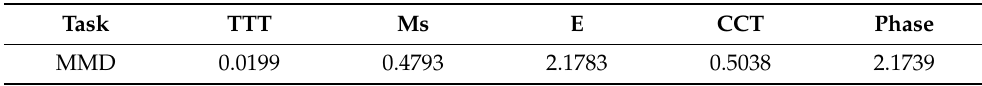
Table 2. MMD values between two kinds of data for five tasks.